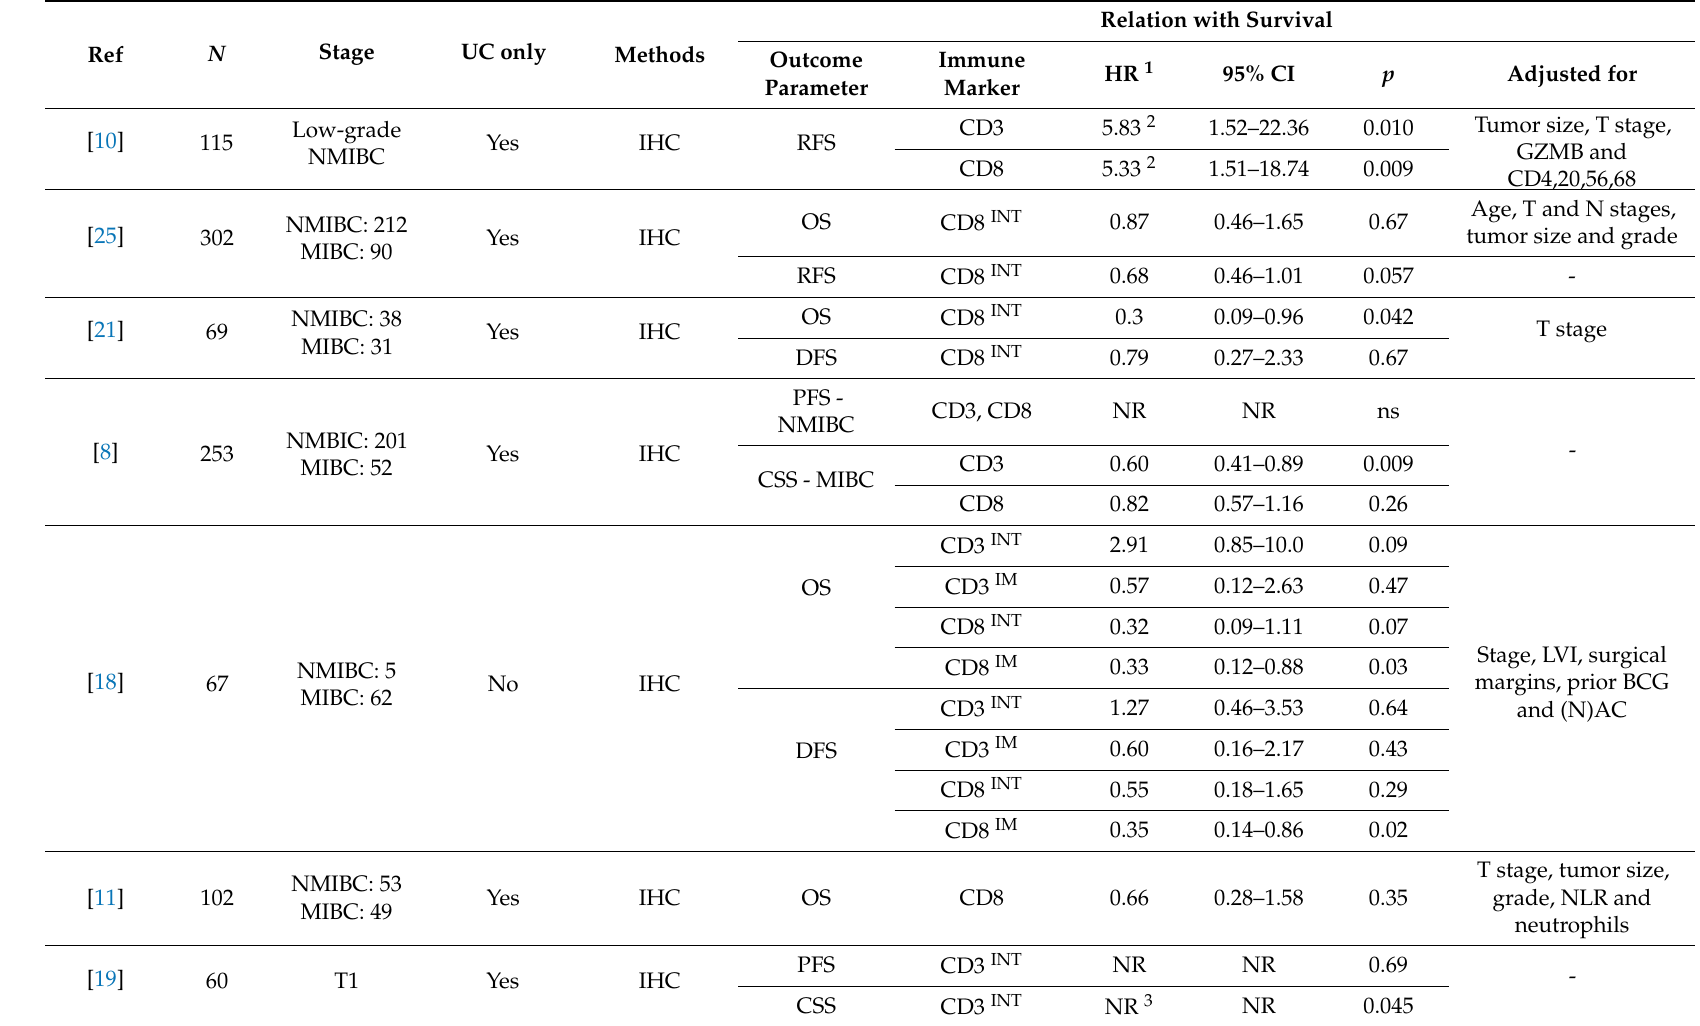
Table 1. Prognostic value of infiltrating CD8 + and CD3 + T